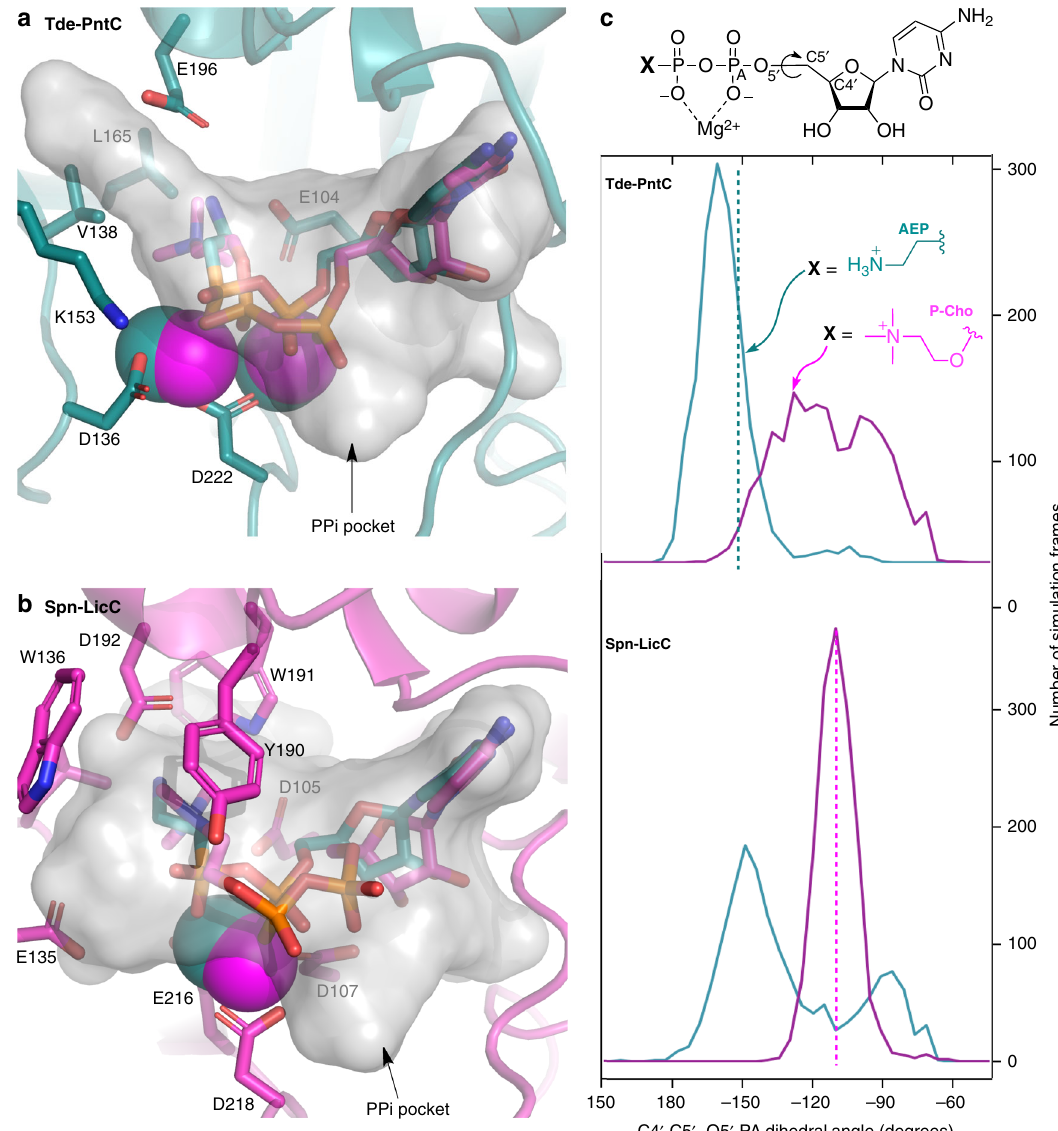
Fig. 5 Molecular dynamics simulations of Tde-PntC (top) and Spn-LicC (bottom). a Representative conformations of the Tde-PntC active site with cognate ligand CMP-AEP and Mg 2 + ions colored teal; non-cognate ligand CDP-Cho and Mg 2 + ions are magenta. The transparent gray surface representation denotes the 287 Å 3 cavity calculated from the crystal structure (minus CMP-AEP) using the Roll algorithm of POCASA 42 . b Representative conformations of the Spn-LicC active site showing the cognate ligand CDP-Cho and Mg 2 + ion colored magenta; non-cognate ligand CMP-AEP and Mg 2 + are colored teal. Transparent gray surface outlines the 381 Å 3 cavity calculated from the 1JYL crystal structure coordinates after removing CDP-Cho (26). c Histogram of C4 ′ -C5 ′ -O5 ′ -PA dihedral angles sampled during 10 × 150 ps independent simulations for each protein:ligand pair, using the same color scheme for each ligand (CMP-AEP = teal; CDP-Cho = magenta). Dotted lines represent crystallographically observed dihedral